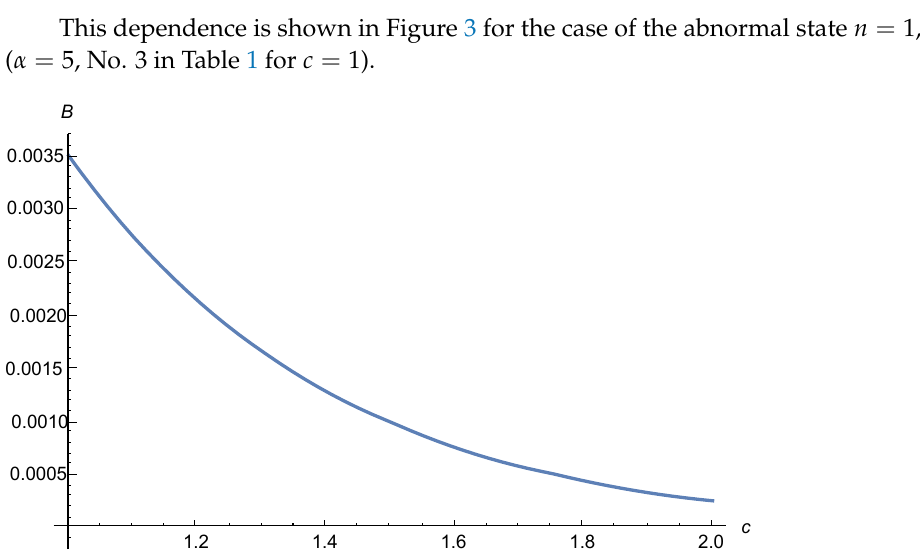
Figure 2. Dependence of the binding energy B of the state n = 1, κ = 0 (normal) for α = 5 on the speed of light c .